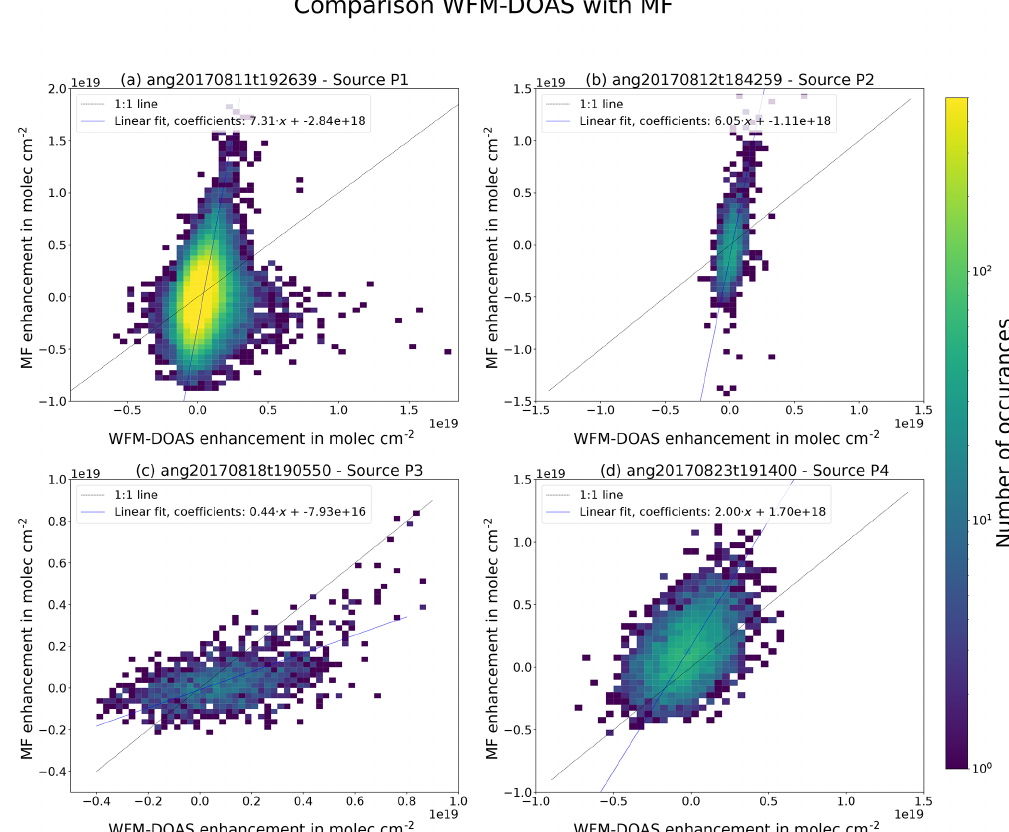
Figure D1. Similar to Fig. 11 but for the plume regions